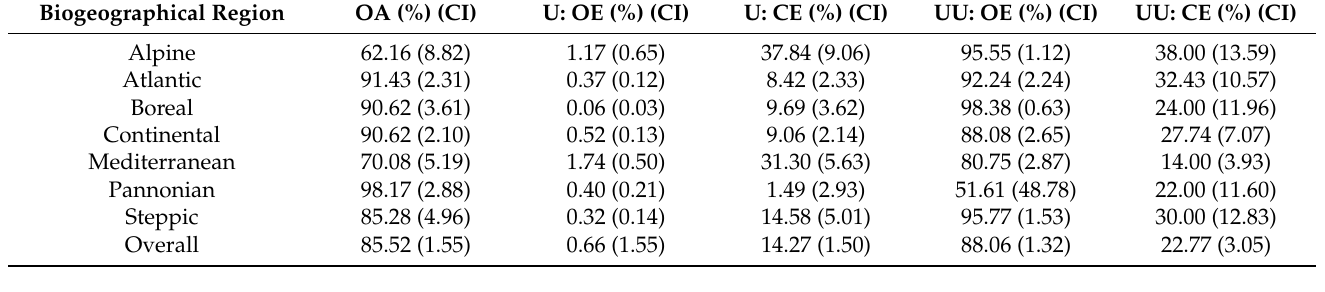
Table 4. Area-based accuracy measures of the classification per biogeographical region and overall. Biogeographical Region